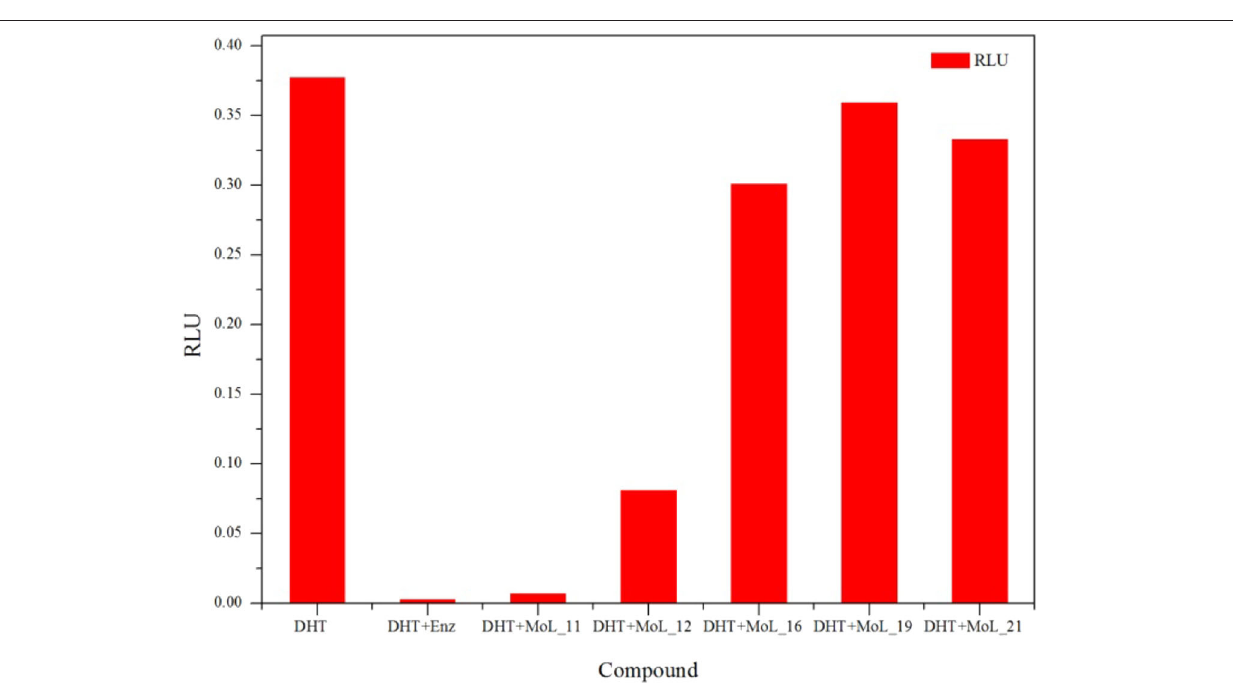
FIGURE 3 | Dual luciferase gene report